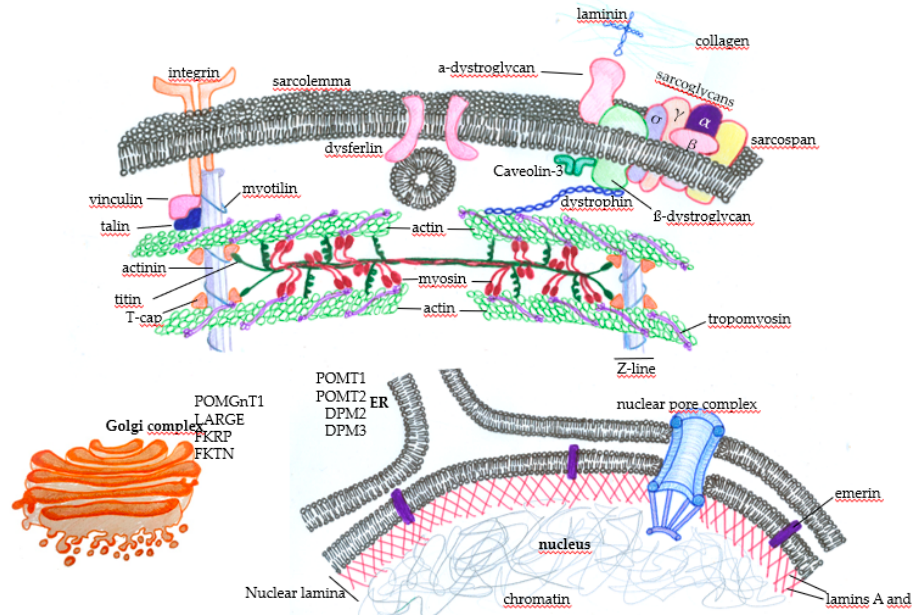
Figure 2. Subcellular distribution of some proteins that, when genetically altered, lead to muscular dystrophies. In the sarcolemma, there are proteins, such as the components of the dystrophin- associated glycoprotein complex (DGC) ( α -dystroglycan, σ , γ , β , and α sarcoglycans, sarcospan, and β -dystroglycan), that physically mediate the interaction of the extracellular ambience with the cytoplasm through the binding of laminin with extracellular matrix components such as collagen. The protein dystrophin mediates the integration of the complex with actin filaments, composing the contractile structures of the muscle cytoskeleton. The concerted action of these proteins protects the muscle fibers against cellular damage during the cycles of contraction. Membrane integrins also interact with extracellular matrix components and provide normal muscle function and contraction through the integration with intracellular components. Under physiological circumstances, when there is the disruption of the sarcolemma, the action of dysferlin mediates membrane repair to avoid cell death. Many proteins play essential roles in maintaining normal muscle function and contraction force, such as vinculin, talin, and myotilin, alongside titin, T-cap (composing the Z line), tropomyosin, and the main contractile components, myosin and actin. Nuclear proteins such as emerin, which anchors the nuclear lamina components lamin A and C, can also induce muscular dystrophies when genetically mutated. Finally, alterations in the glycosylation patterns of proteins such as (protein o-mannosyltransferase) POMT1, POMT2, (dolichol-phosphate-mannose) DPM2, and DPM3 in the endoplasmic reticulum (ER) and (protein O-mannose b-1, 2-N-acetylglucosaminyltransferase) POMGnT1, (like-glycosyltransferase) LARGE, (Fukutin-related protein) FKRP, and (Fukutin) FKTN in the Golgi complex deeply affect muscle function and lead to muscular dystrophy.